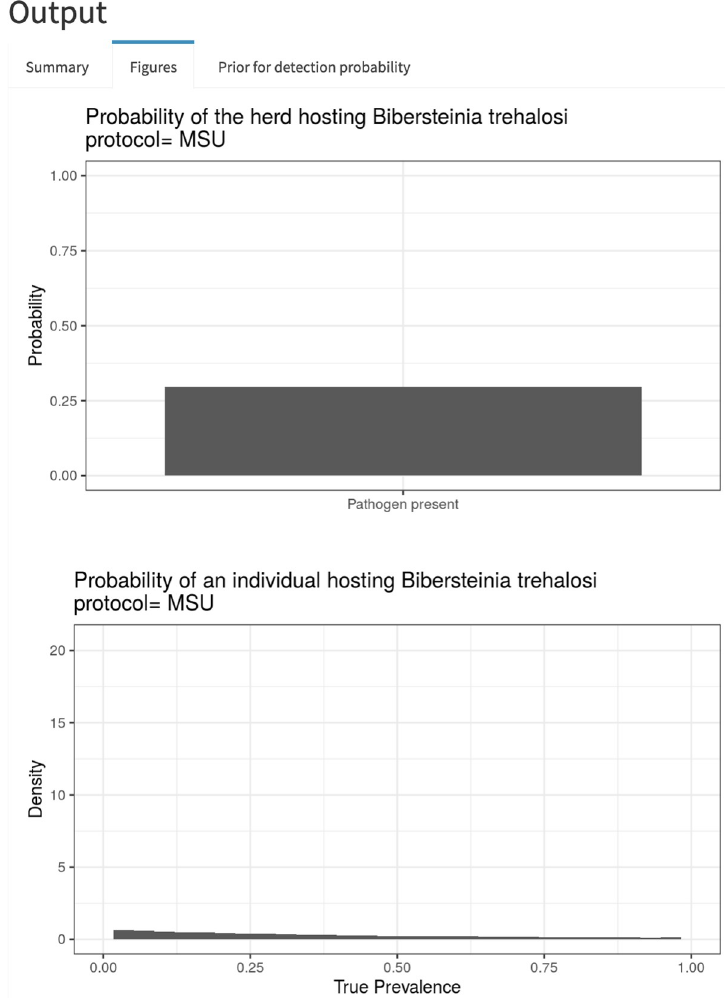
Fig 5. Graphs of the approximate posteriors for the probability of a herd being free from a pathogen and pathogen prevalence for a hypothetical example. In this hypothetical example, 0 out of 20 animals tested positive for Bibersteinia trehalosi using the MSU testing